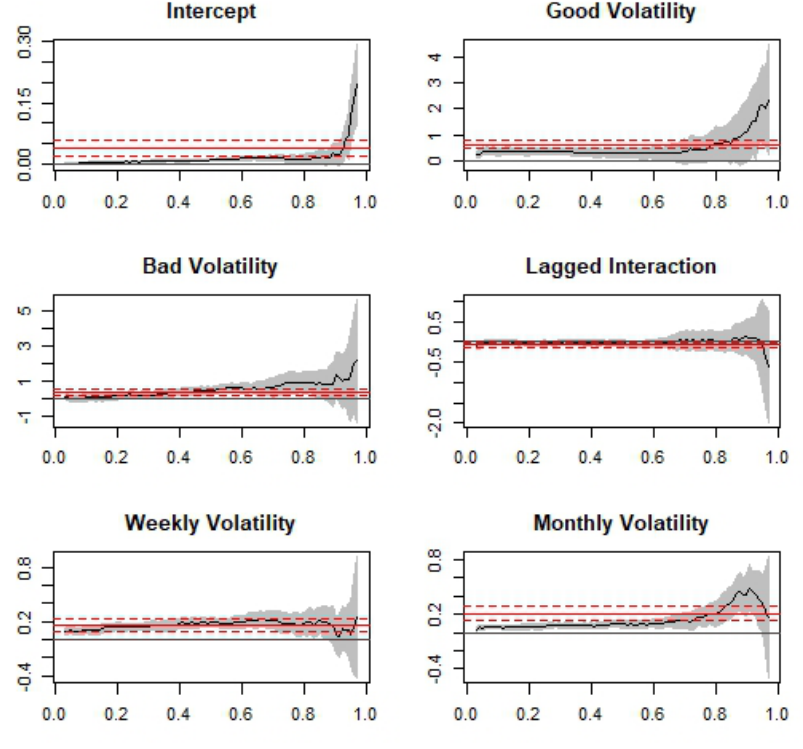
Figure 7. Model 5: HAR-RV-QR results—1-day ahead.